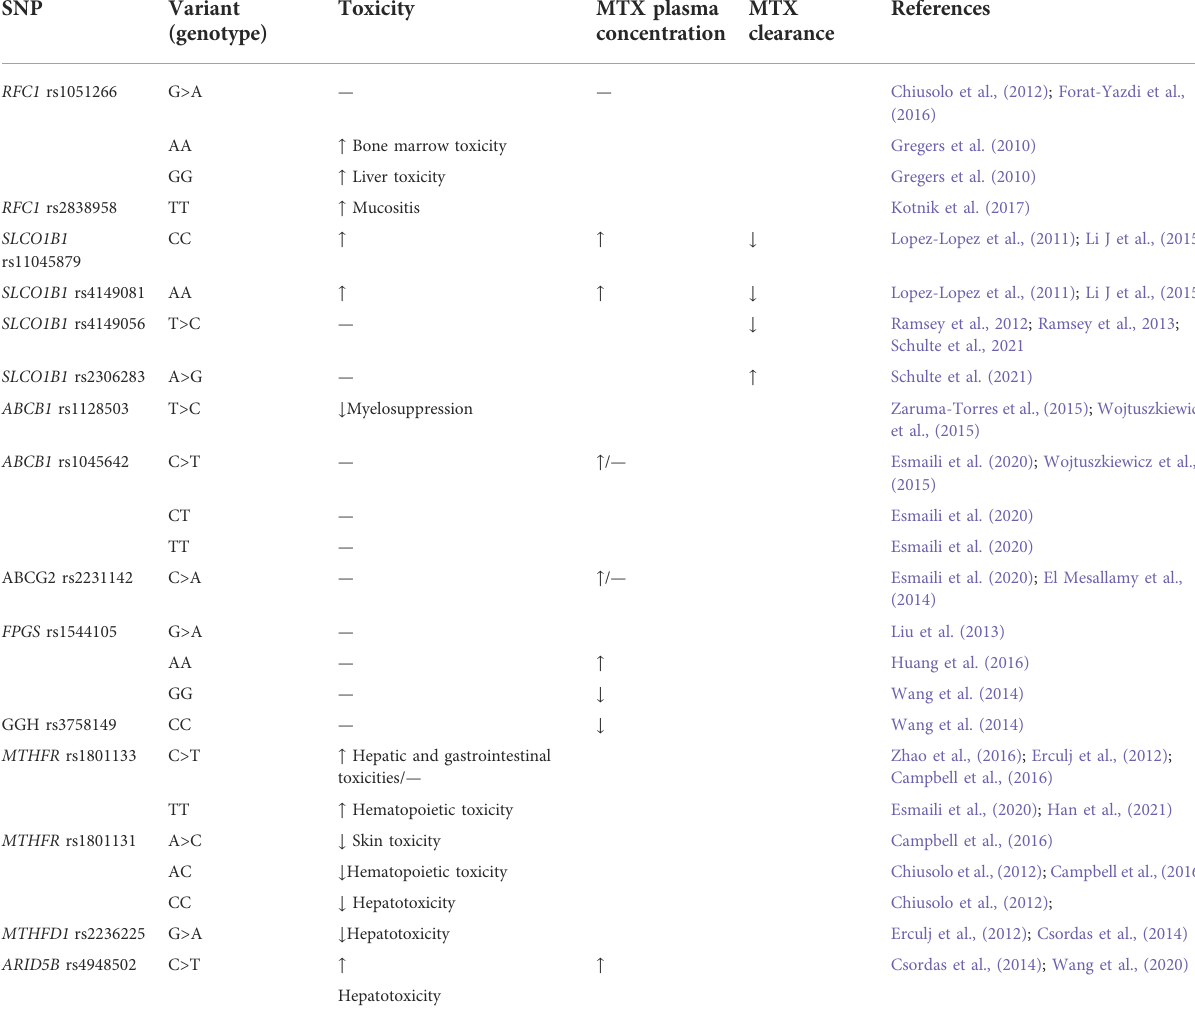
TABLE 1 Gene polymorphisms and their correlation with MTX plasma levels and MTX-induced